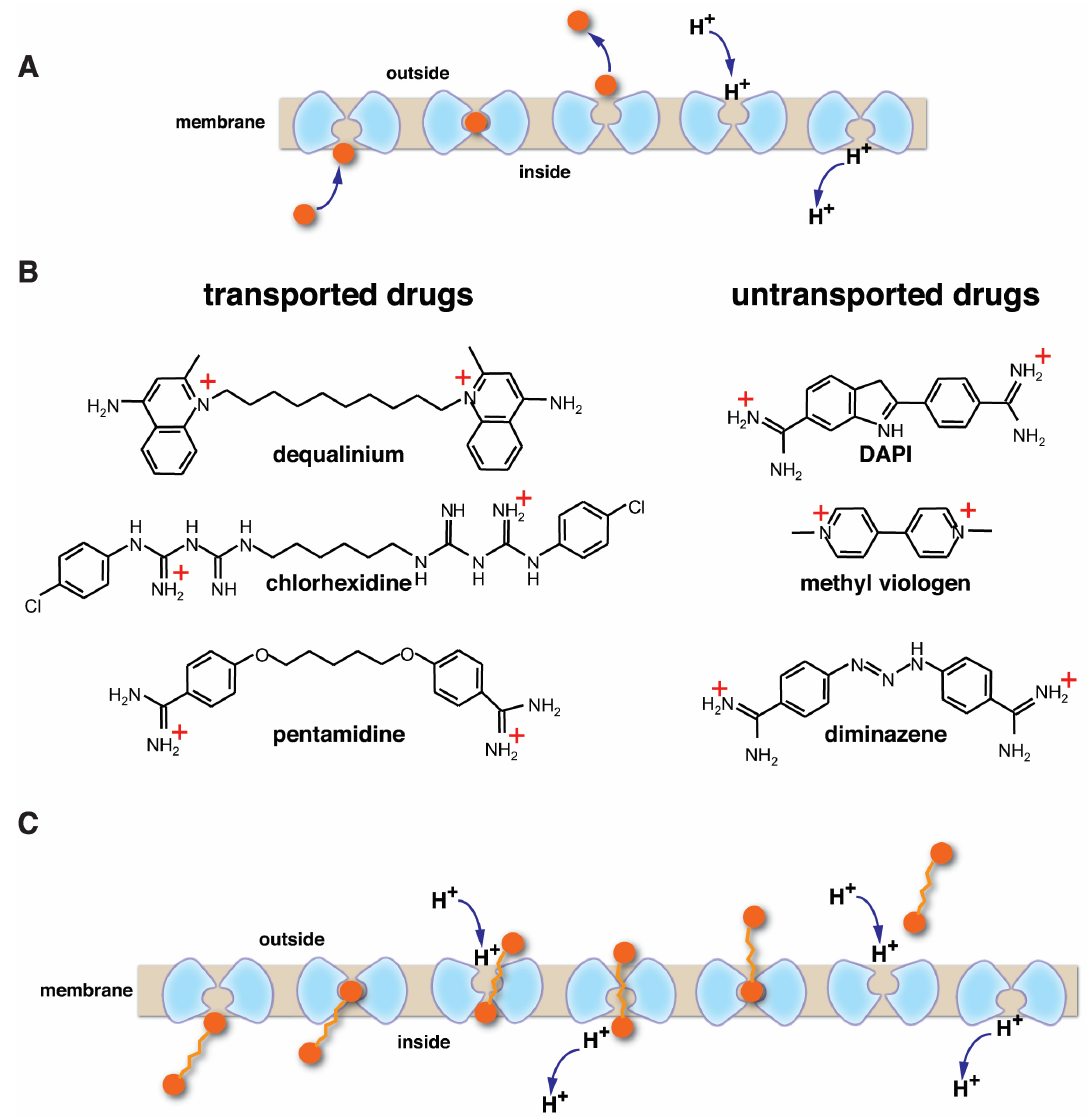
FIGURE 1: (A) General mechanism for H + -coupled solute antiport. Note that most transporters have an internal 2-fold symmetry axis and a monomeric transporter is represented here by two symmetrical parts, shown in light blue. The substrate is indicated by orange sphere. The occluded state is second from the left. (B) Chemical structure of divalent cationic drugs that are transported or untransported by MdfA. (C) Illustration of the suggested processive antiport